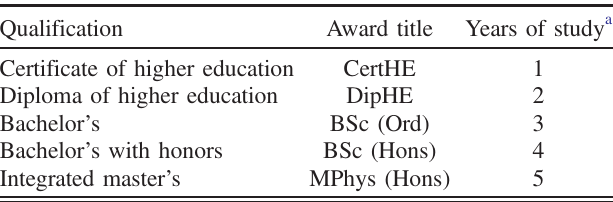
TABLE I. Scottish undergraduate qualifications, including commonly used award titles for physics degrees.